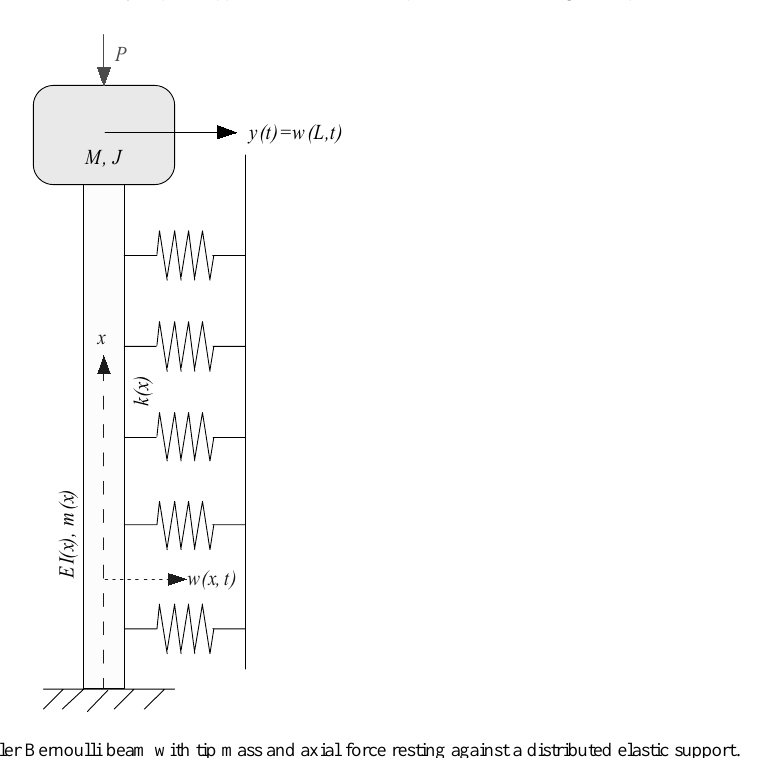
Fig. 10. Combined pile-soil model using Euler Bernoulli beam with tip mass and axial force resting against a distributed elastic support. M . The mass per unit length of the beam is m , r is the radius of gyration and the beam is subjected to a